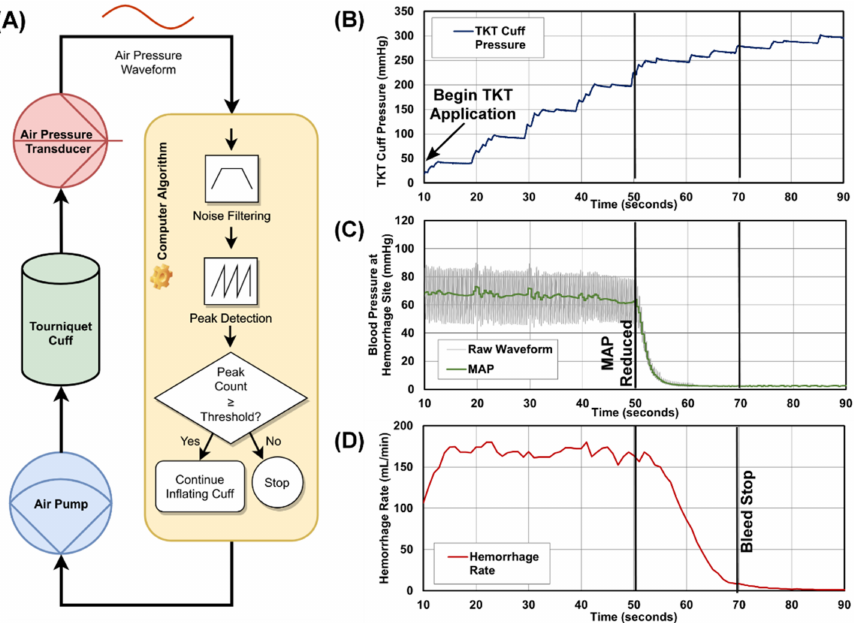
Figure 1. Overview of the Self-Tightening Auto-Tourniquet (aTKT) system. ( A ) Process flow diagram for the aTKT algorithm mechanism. An air pressure sensor attached to the pneumatic pressure cuff sensed pressure oscillations and continued tightening through a closed-loop feedback mechanism until these oscillations were not detected. ( B – D ) Representative results for the aTKT for ( B ) air pressure in the pneumatic cuff, ( C ) arterial waveform data, and ( D ) hemorrhage rate vs. time. The aTKT was engaged at time shown on the plot and reduction in MAP and bleed stop are noted on the